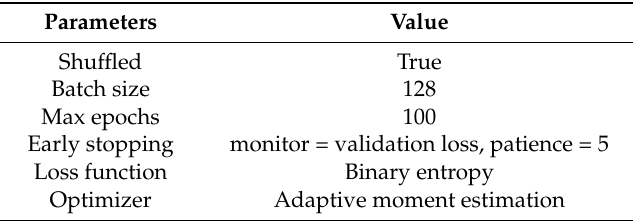
Table 4. Training details and